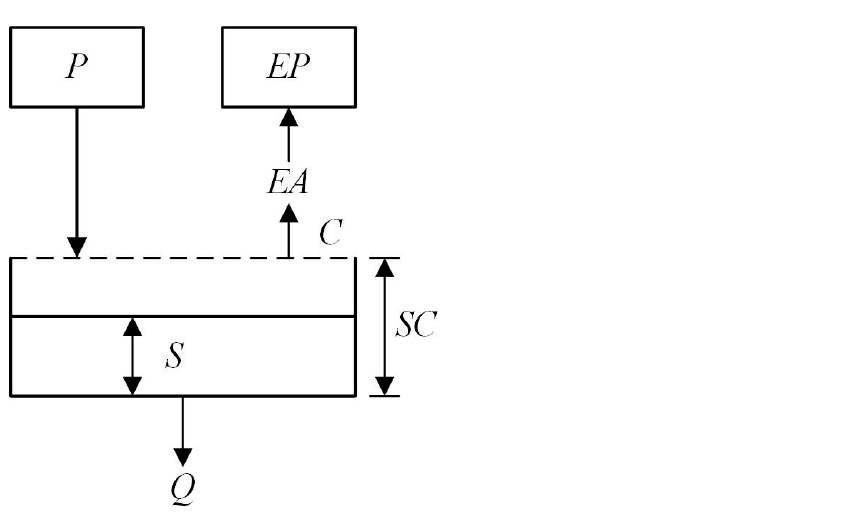
Figure 2. Structure of two-parameter monthly water balance model.